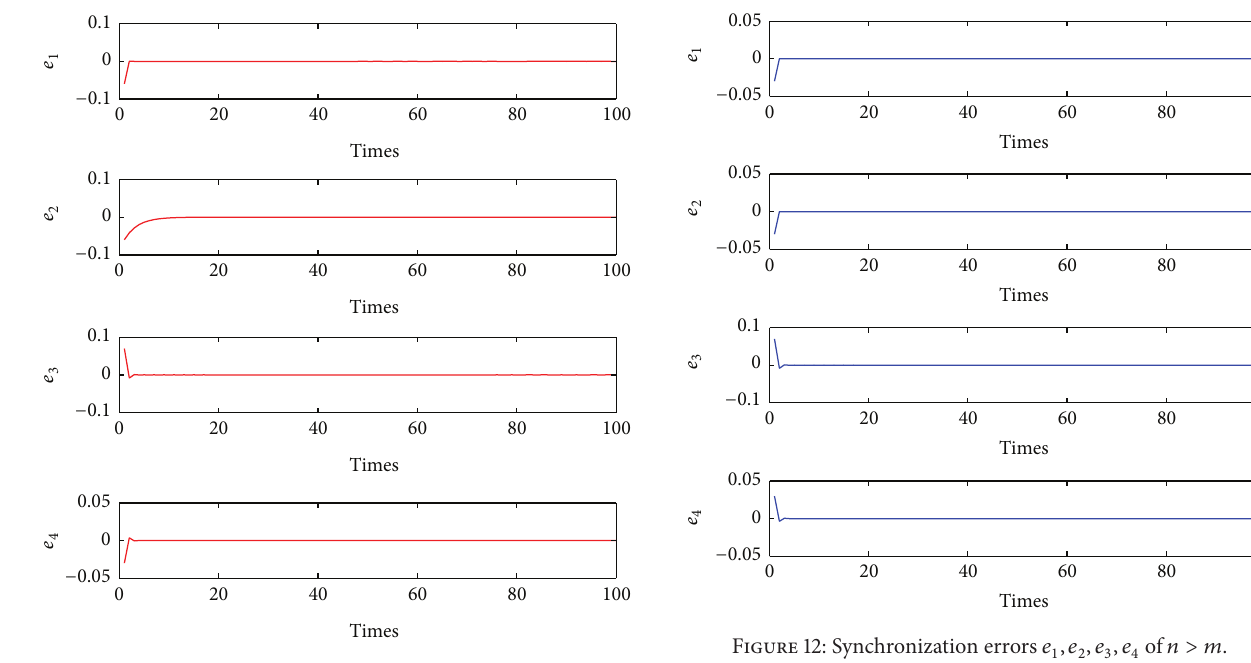
Figure 10: Synchronization errors 𝑒 1 ,𝑒 2 ,𝑒 3 , 𝑒 4 of 𝑚 = 𝑛 .